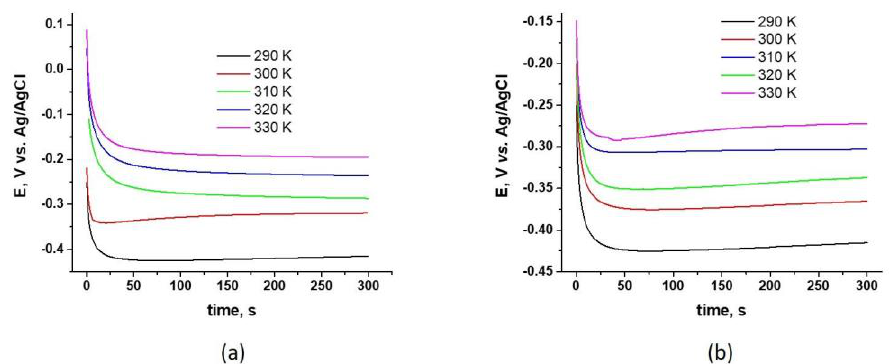
Figure 2. Open circuit potential behavior at different temperatures of electrolyte for: ( a ) NiCr alloy; ( b ) CoCr alloy.